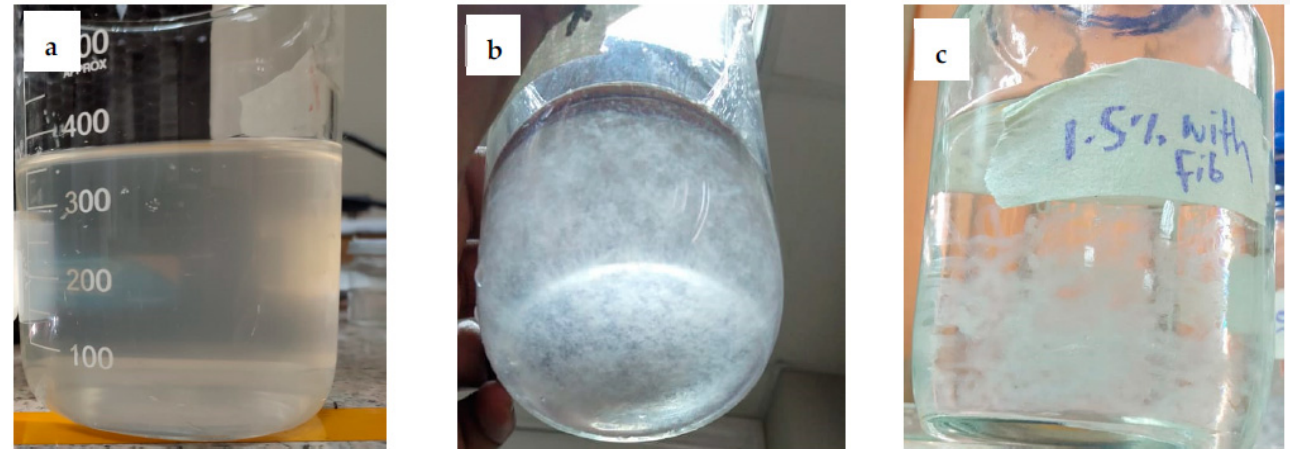
Figure 1. ( a ) Prepared alginate solution, ( b ) cotton fibers dispersion in alginate solution, ( c ) cotton reinforced alginate hydrogel fibers.